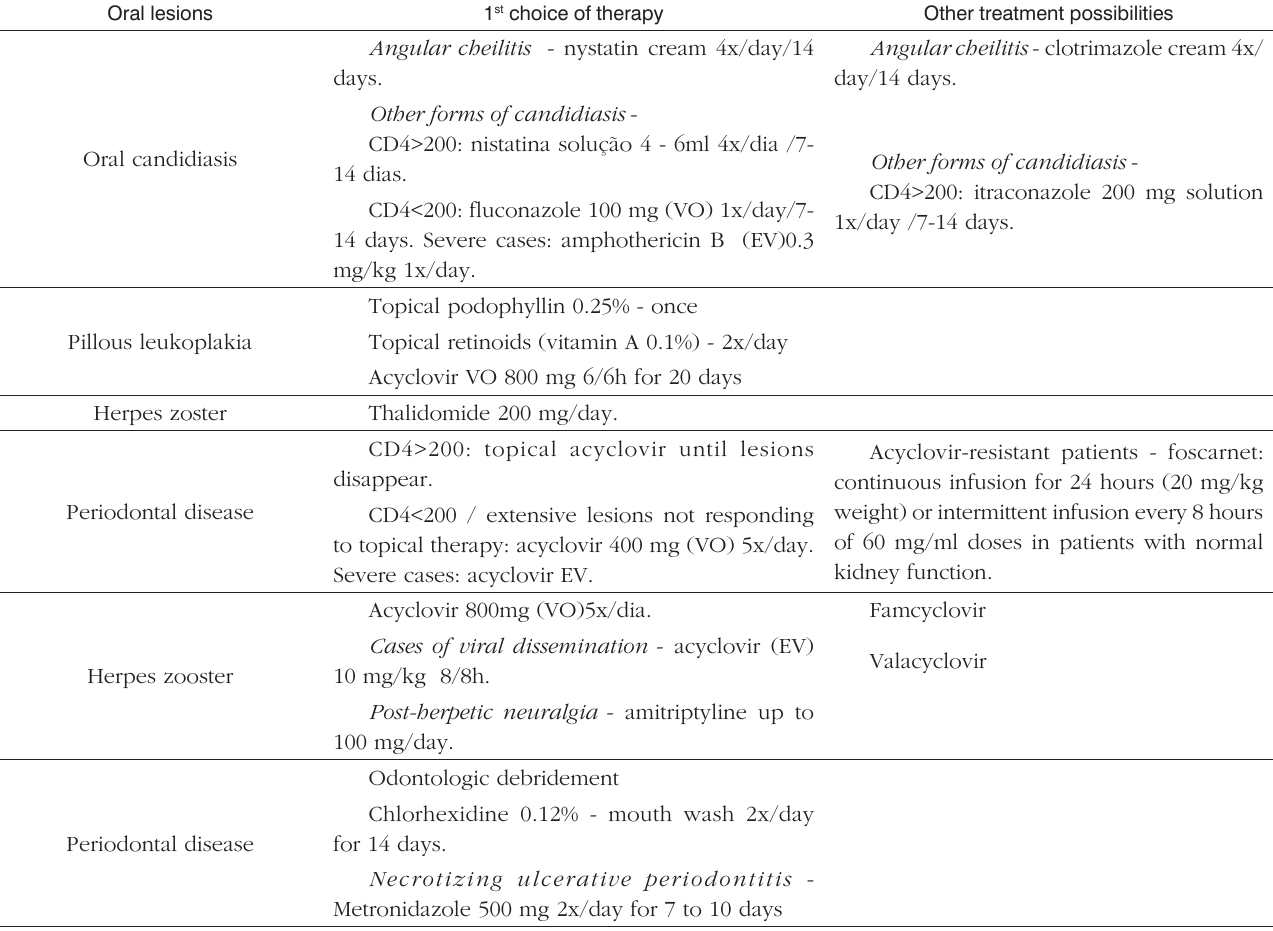
Table 1. Treatment of the main oral manifestations of the HIV patient Oral lesions 1 st choice of